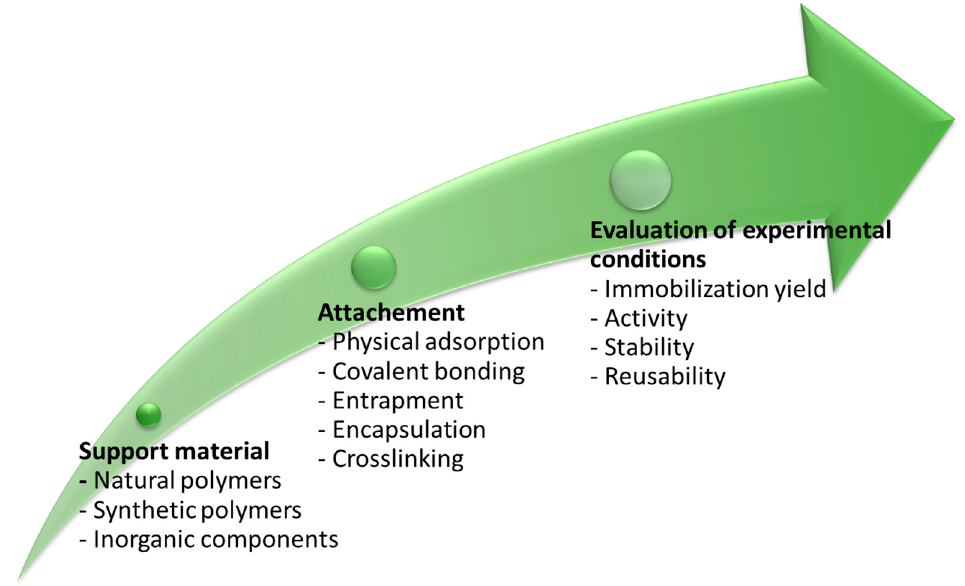
Figure 5. Steps for immobilization of bioactive enzymes. Immobilization methods and carriers utilized for immobilization of bromelain in